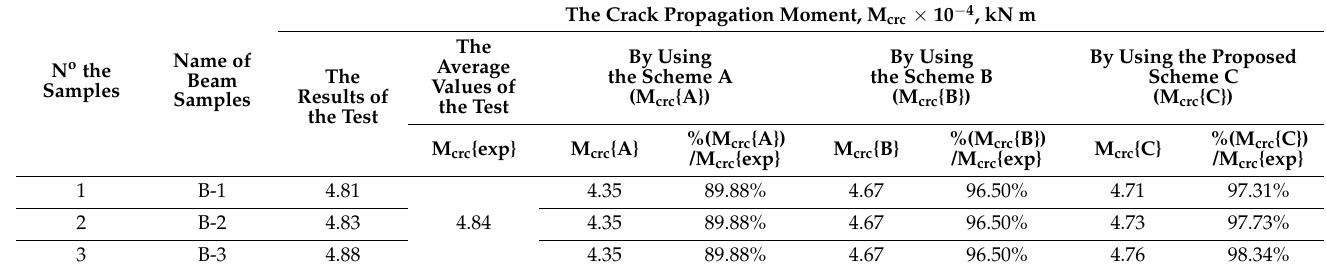
Table 8. The experimental and calculated crack propagation